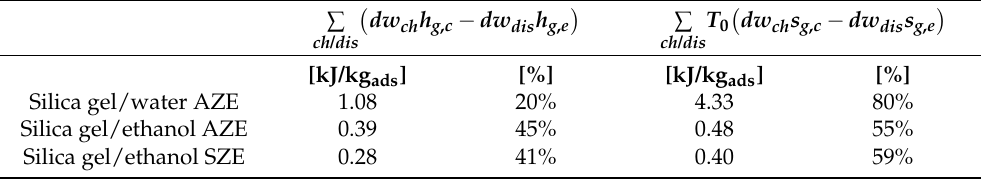
Table 3. Breakup of the exergy change and enthalpy and entropy percentage contributions over the entire heat charging/discharging cycle.